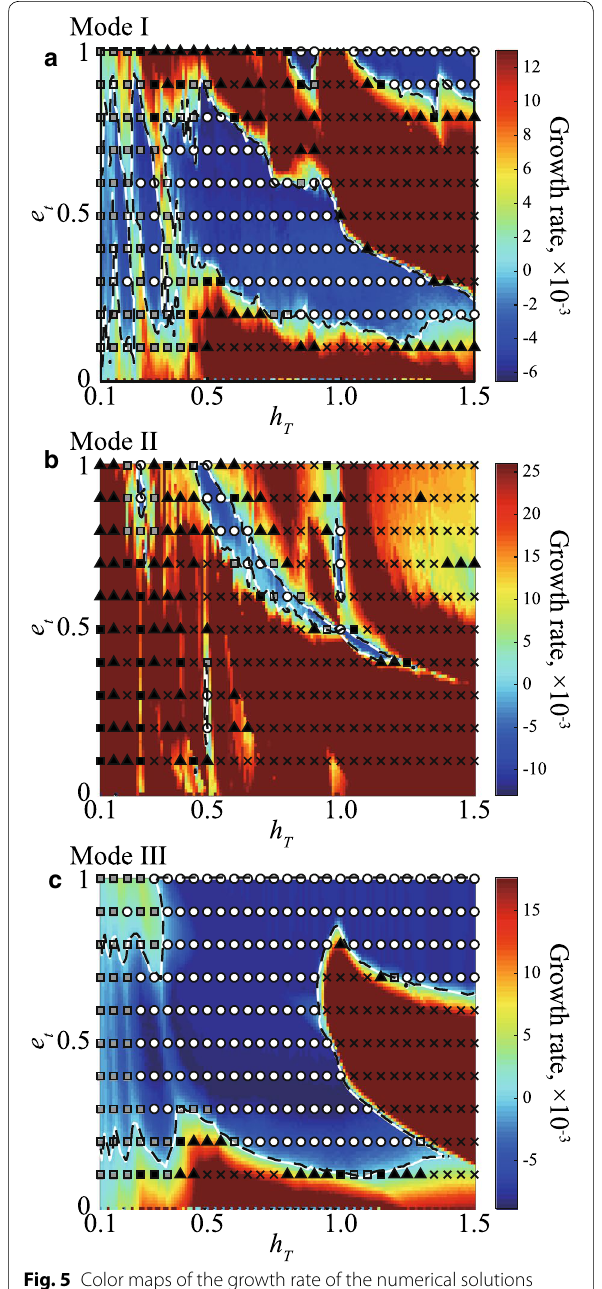
Fig. 5 Color maps of the growth rate of the numerical solutions in the stability analysis using CM for a Mode I, b Mode II, c Mode III conditions. The color bars denote the range from the minimum value to − 2 times it. Zero growth rate is indicated by white-black dashed lines. Results of the stability analysis by Tada and Madariaga (2001) are indicated in symbols. For full details, see the main text